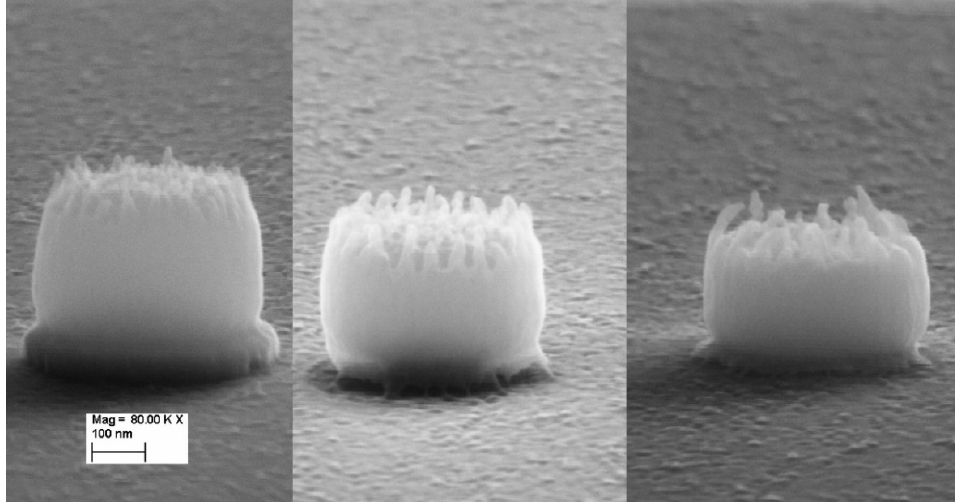
Figure 7. Plasma chemical etching of samples in an SF 6 atmosphere. For the left sample, the etching time was 30 s; for the sample in the center, it was 45 s; for the right sample, it was 60 s.